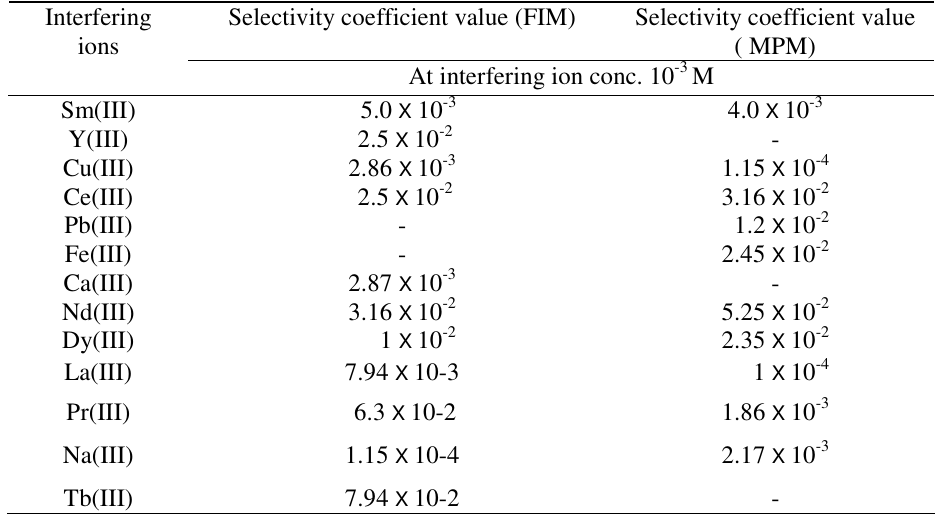
Table 4. Selectivity coefficient values for Gd(III) ion selective electrode based on matched potential method and fixed interference method.